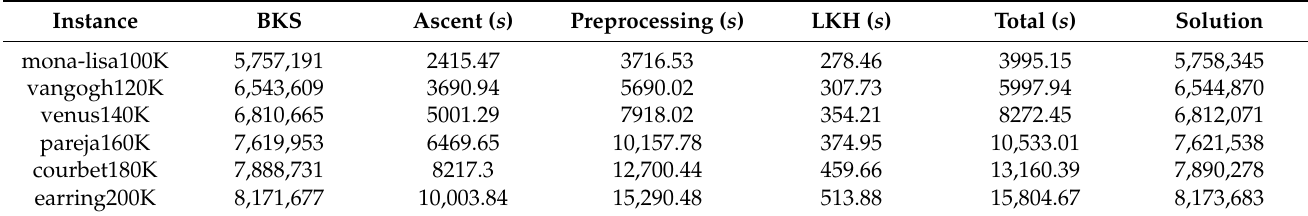
Table 1. The results of LKH with single core on some large-scale